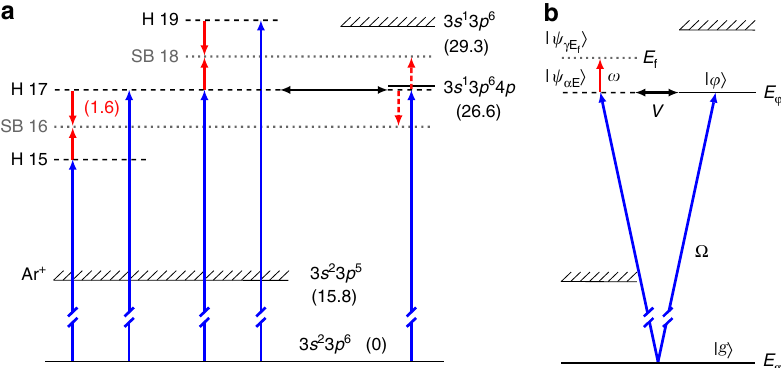
Figure 1 | Energy diagrams. ( a ) Ar energy diagram showing the states, channels and processes involved in the present work. The blue arrows represent ionization at different harmonic frequencies. The red arrows denote absorption or stimulated emission of infrared photons. Energies (in eV) are indicated in parentheses. The energy of harmonic 17 can be tuned across the 3 s (cid:2) 1 4 p resonance, which decays by autoionization (black arrow). The processes indicated by the red dashed arrows are found to be weak, as discussed below. ( b ) Energy diagram presenting some of the theoretical notations used in this work. c a E denote continuum wavefunctions with energy E and angular momentum a , c are final continuum wavefunctions with angular momentum g and energy E f . g E f The excited bound state is described by the wavefunction j and the energy E j . g and E g are the ground-state wavefunction and energy. O and o are the XUV and infrared photon energies. V represents the configuration (Coulomb)